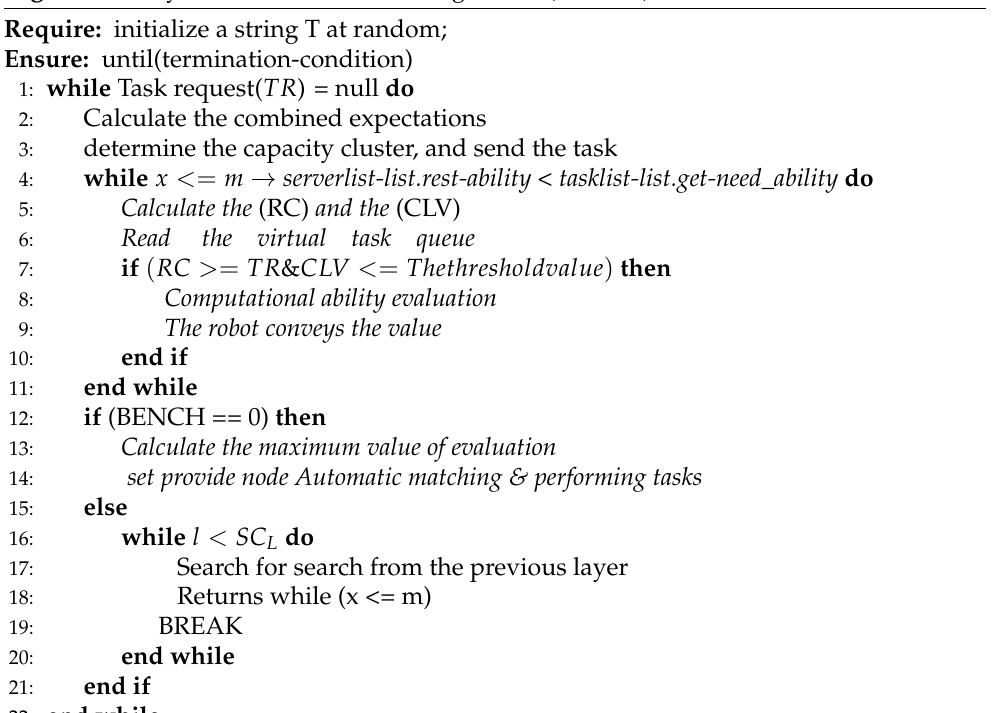
Algorithm 1 Dynamic Reconstruction Algorithm (DRA-M)